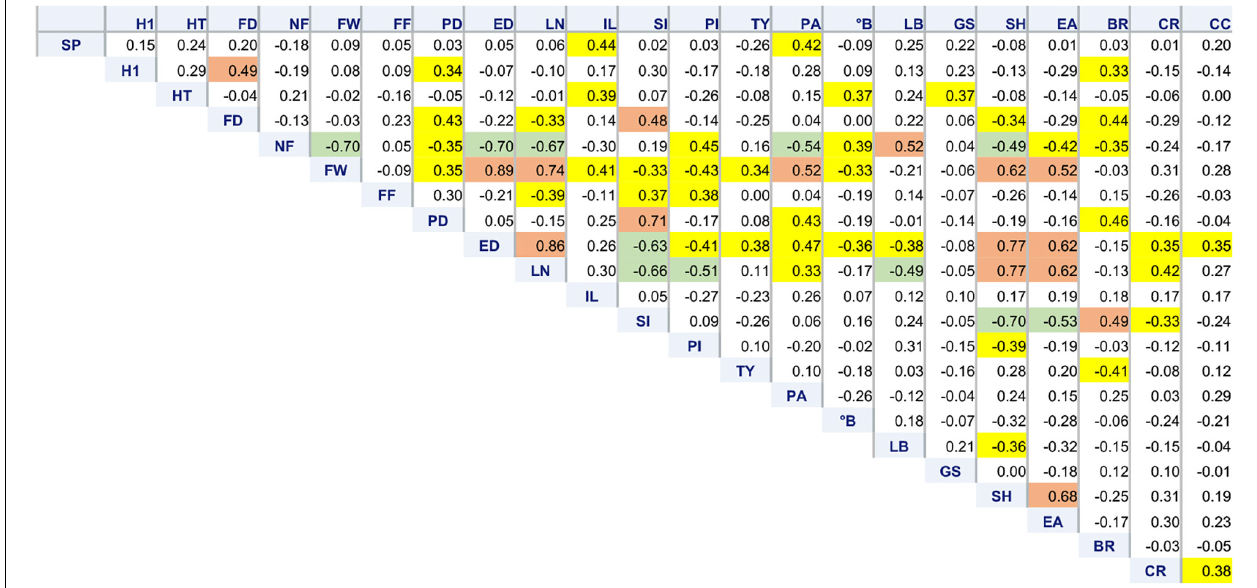
and 11.6%, respectively ( Supplementary Figure 2A ). FW and